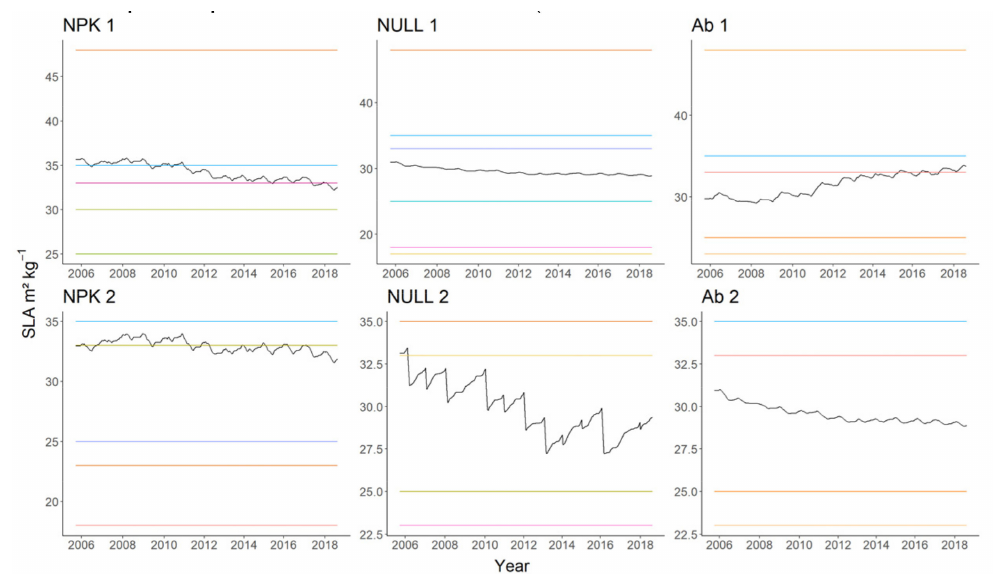
Figure 5. Daily changes in the specific leaf area (SLA) of the community during the simulation period compared to the fixed values set for the plant species (coloured lines as in Figure 4) present in the community (horizontal lines, overlapping for the same values) for three treatments (NPK: fertilised; Null: unfertilised; Ab: abandoned) and two blocks (1, 2).